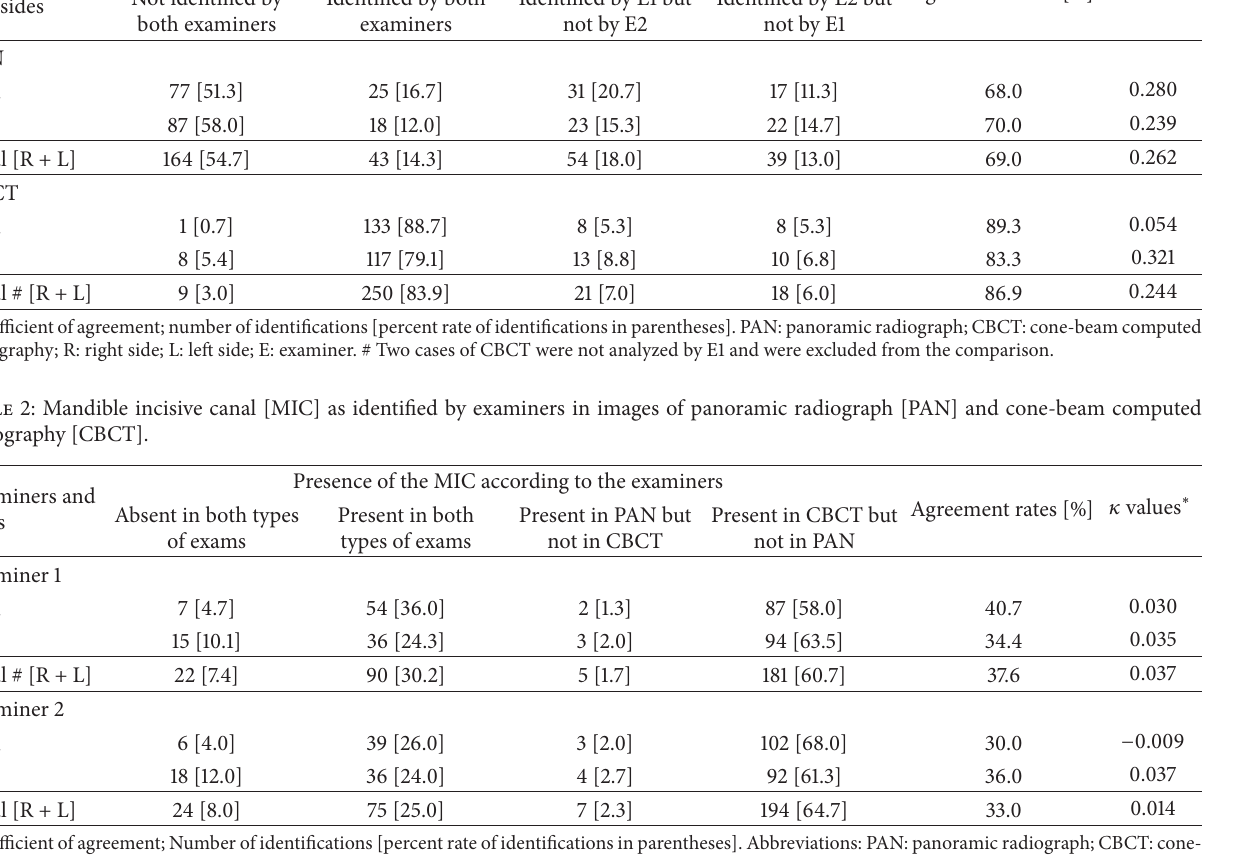
Table 1: Agreement between examiners by type of examination for identification of the mandible incisive canal [MIC]. Identification of the MIC by examiners E1 and E2 Type of exams Agreement rates [ % ] 𝜅 values Not identified by Identified by both Identified by E1 but Identified by E2 but and sides both examiners examiners not by E2 not by E1